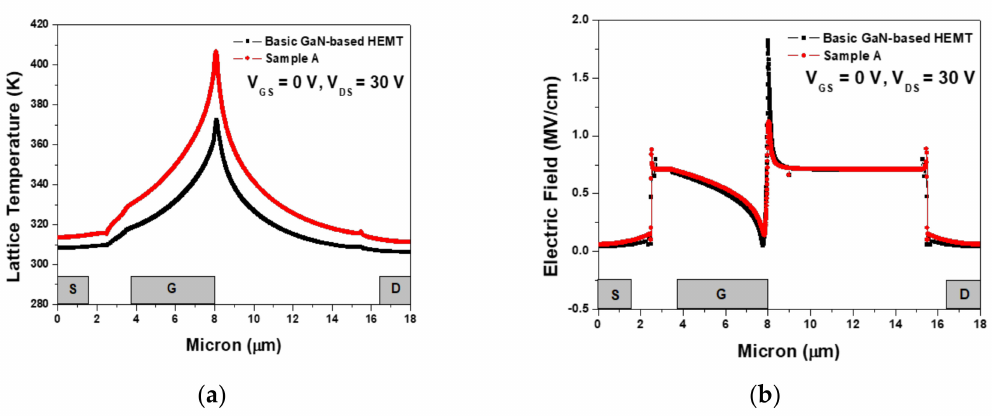
Figure 7. ( a ) Lattice temperature, and ( b ) electric field distributions across the 2-DEG channel layer with and without the Si 3 N 4 dielectric layer at V GS = 0 V and V DS = 30 V.